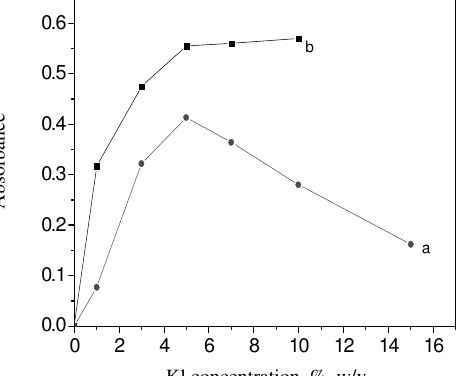
Figure 4. Effect of KI on the extraction of the complex ion associates [Tz] + .[BiI - chloroform (a) and [Phen] + .[BiI